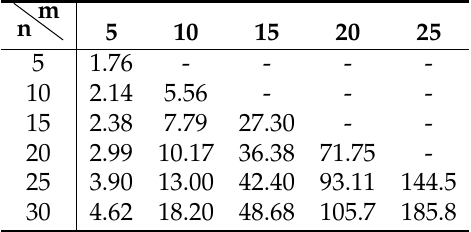
Table A5. Least-squares solution time using Chebyshev polynomials in milliseconds for Problem #2.